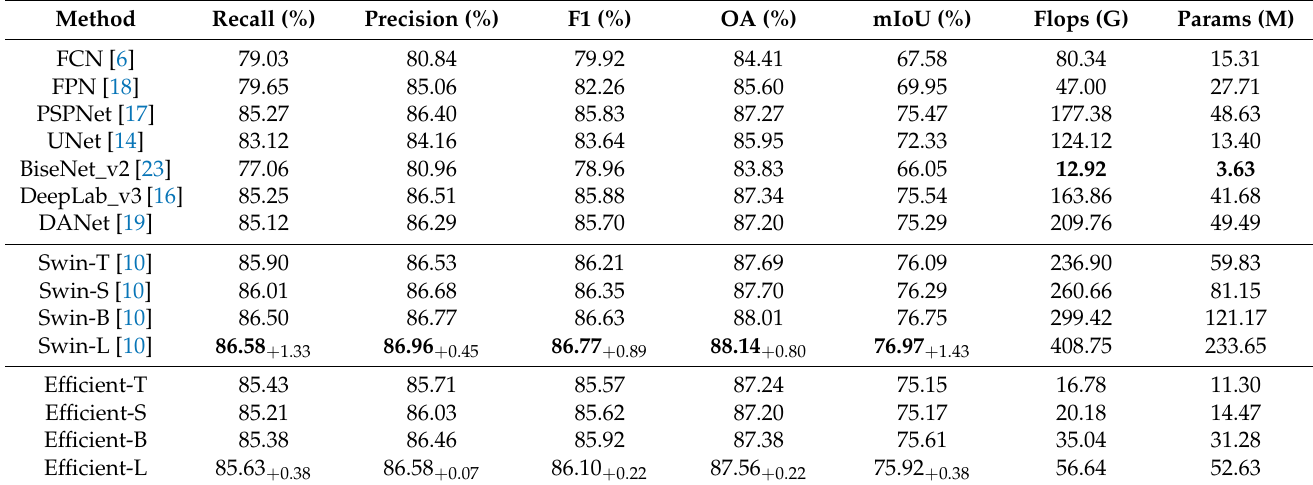
Table 10. Comparison of SOTA methods on the Vaihingen